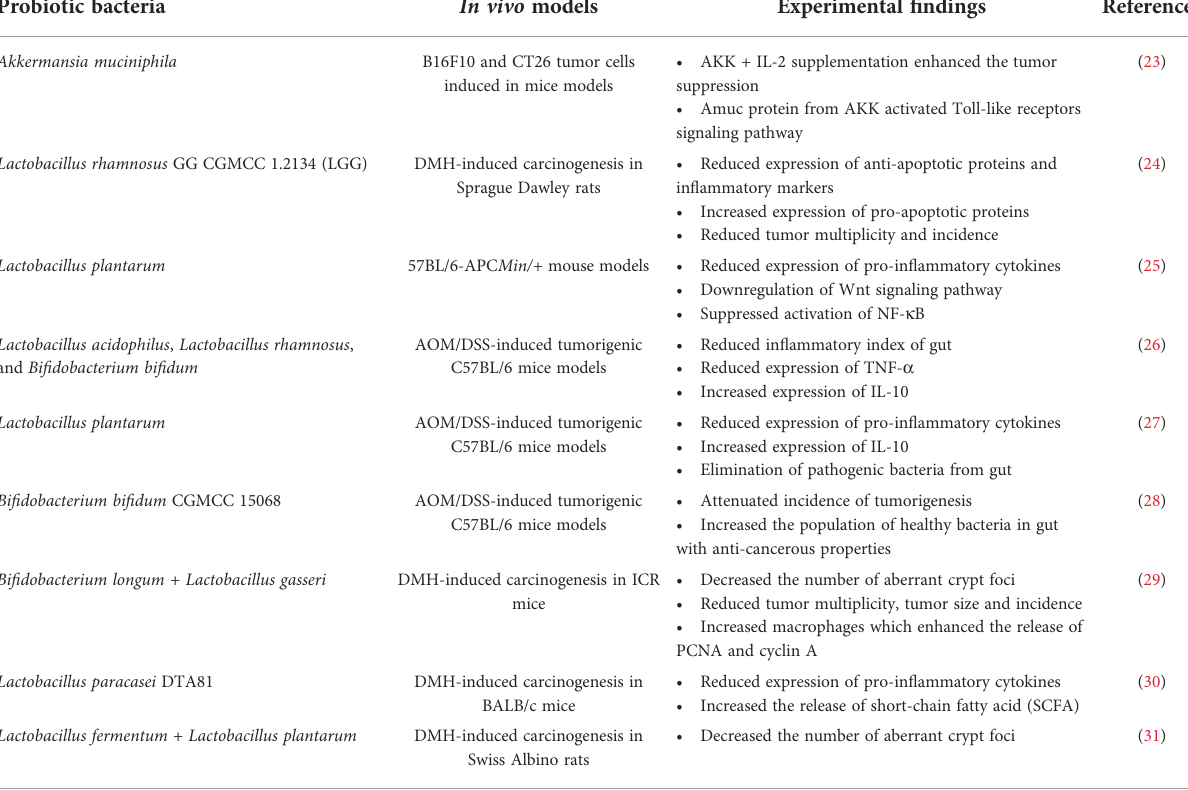
TABLE 2 Anti-tumor effects of probiotic strains in experimental in vivo models in managing colon